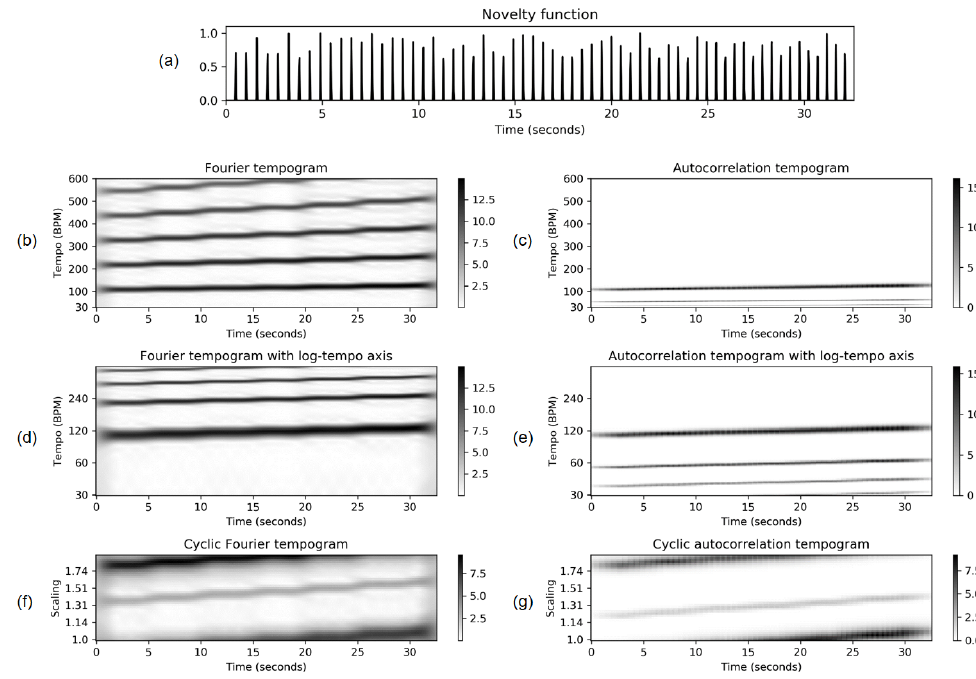
Figure 16. Different tempogram representations of a click track with increasing tempo (110 to 130 BPM). ( a ) Novelty function of click track. ( b , d , f ) Fourier tempogram with linear/logarithmic/cyclic tempo axis. ( c , e , g ) Autocorrelation tempogram with linear/logarithmic/cyclic tempo